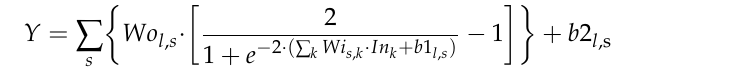
Figure 3. Material properties and boundary conditions for FEM analysis.